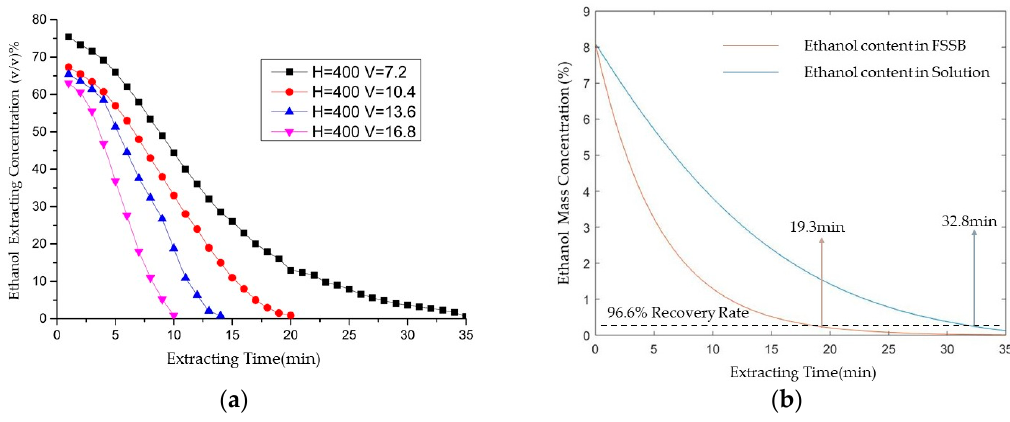
Figure 6. Ethanol concentration change with extracting time; ( a ) Ethanol extracting concentration in different steam flow rate; ( b ) Extracting time comparison between FSSB and solution. di ff erent steam flow rate; ( b ) Extracting time comparison between FSSB and